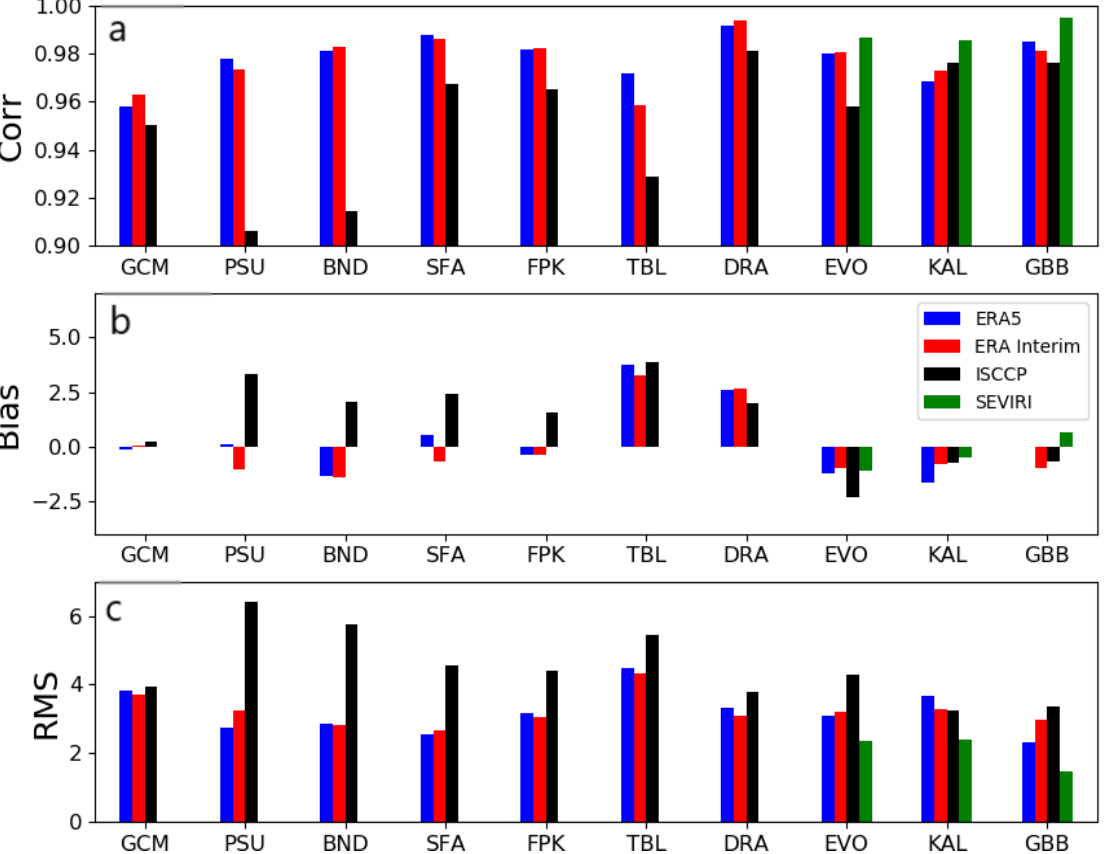
Figure 10. ( a ) Correlation of LST products to the in situ measurements at each station over all the seasons. ( b ) Mean of the differences (Unit: K) in comparison to the in situ measurements at each station over all the seasons. ( c ) Root-mean-square (RMS) of the differences (Unit: K) in comparison to the in situ measurements at each station over all the